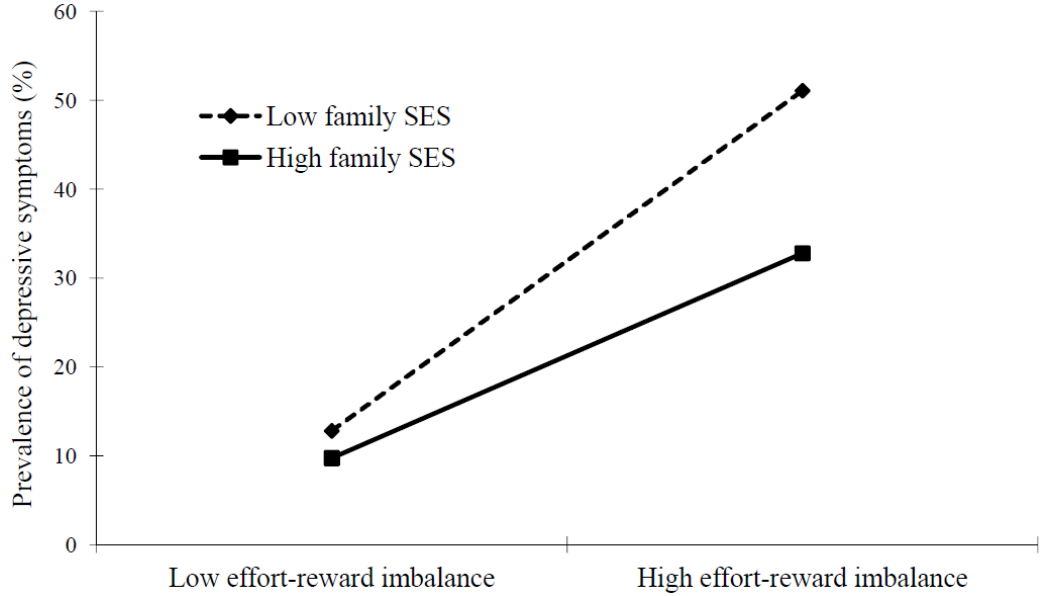
Figure 1. Two-way moderation of school-related stress, family SES and depressive symptoms.